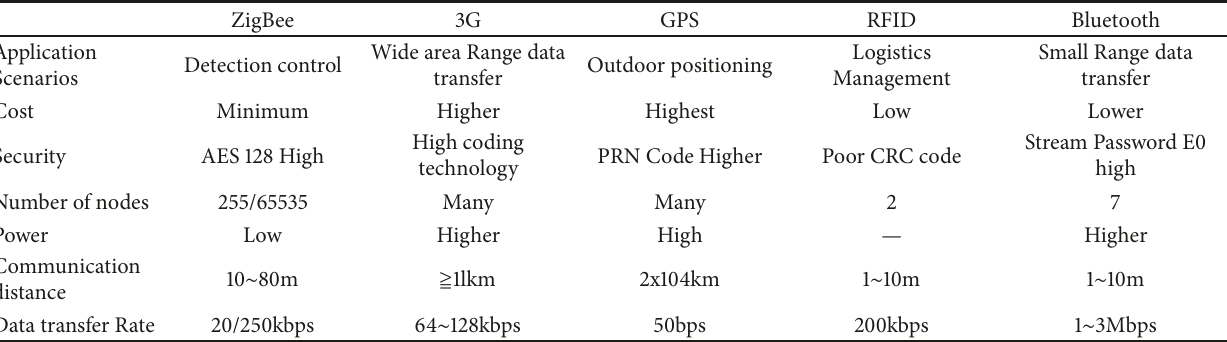
Table 1: Feature comparison items for wireless